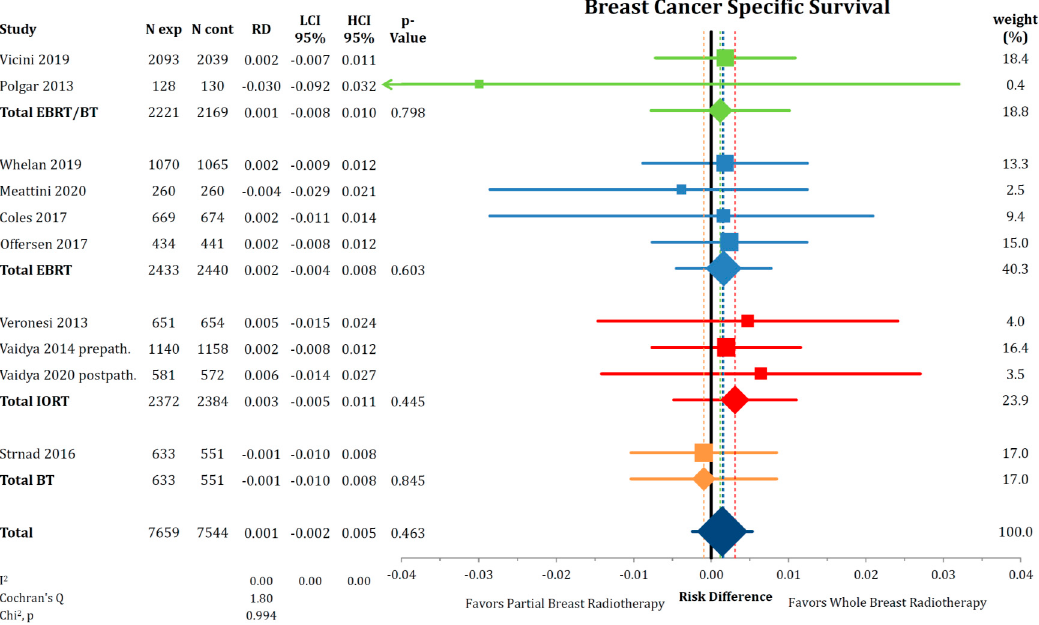
Figure 4. Comparison of breast cancer-specific survival by risk di ff erence between partial- and whole breast radiation using a forest plot and the inverse variance heterogeneity model. Trials are grouped by radiation technique. Quadrats and diamonds represent individual trials and pooled e ff ect sizes with corresponding 95% confidence